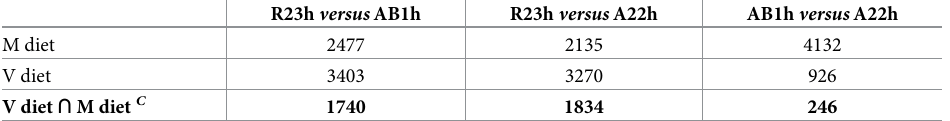
Table 3. Number of differentially expressed probes among conditions after limma t-test (corrected P-value ≤ 0.05, Benjamini-Hotchberg).